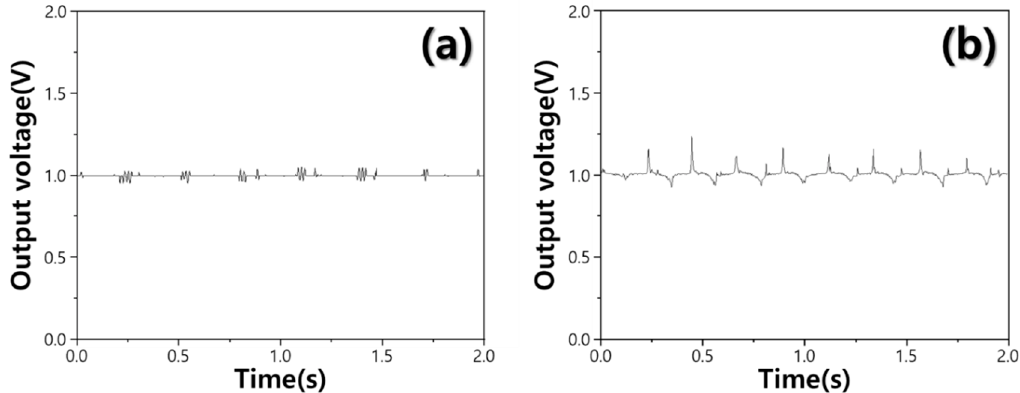
Figure 4. Open-circuit voltage of PVDF fiber generator ( a ) before poling and ( b ) after 2 kV poling.